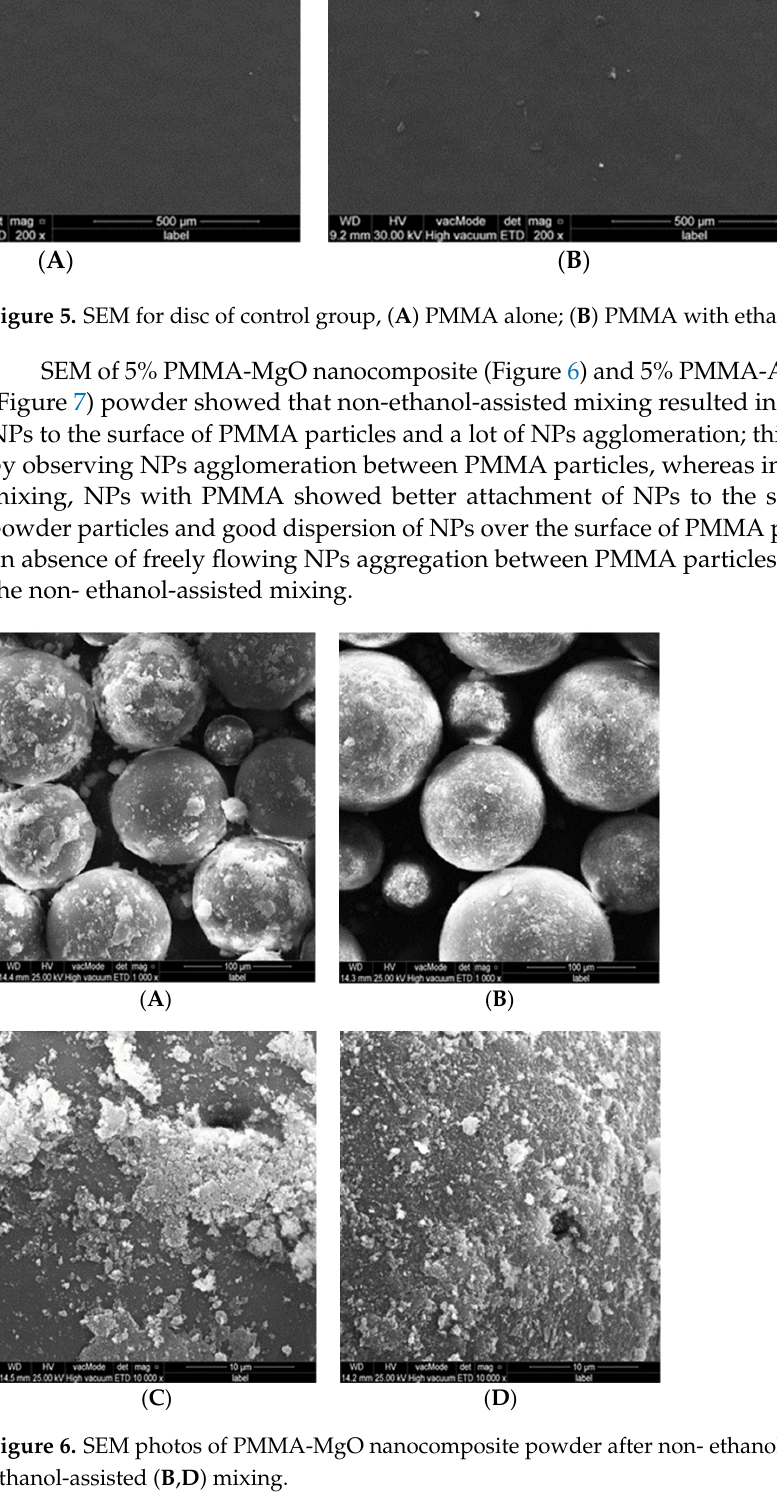
Figure 6. SEM photos of PMMA-MgO nanocomposite powder after non- ethanol-assisted ( A , C ) and ethanol-assisted ( B , D ) mixing.